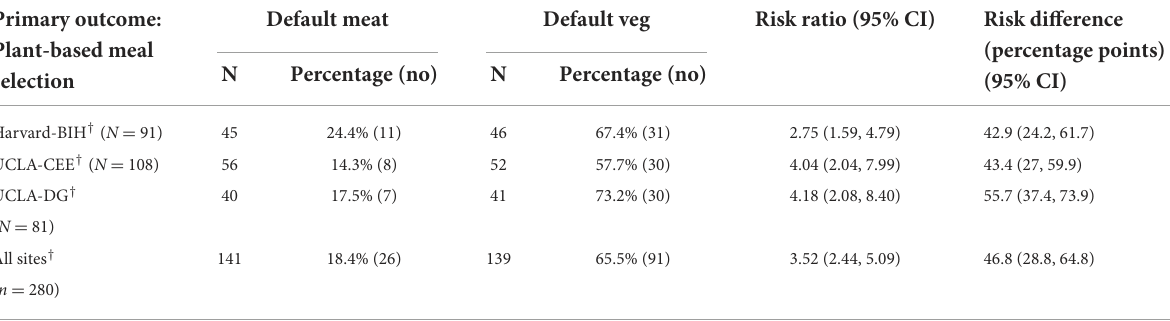
TABLE 4 Percentages, risk ratios, and risk differences of plant-based meal selection among control and intervention groups for three events. Primary